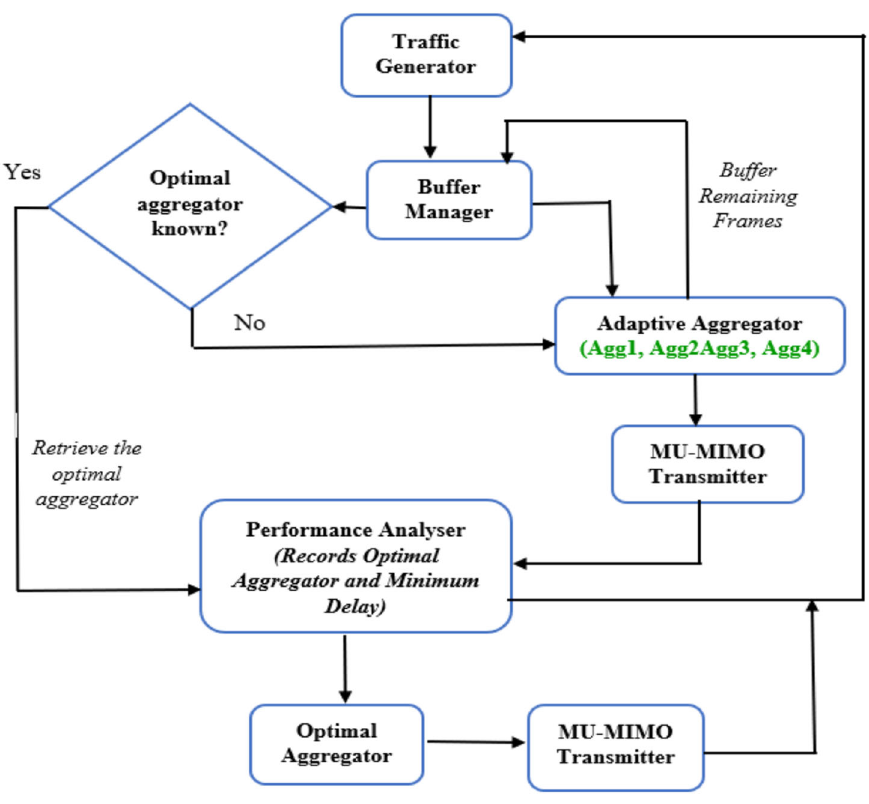
Figure 1. Proposed adaptive aggregation algorithm.